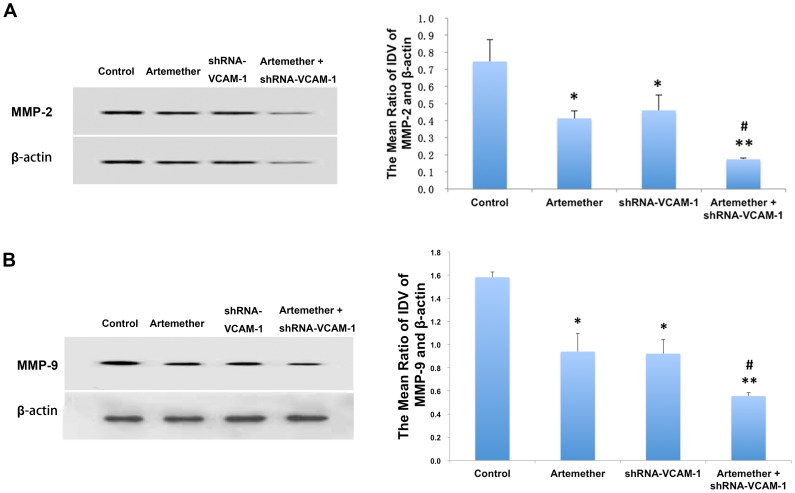
The effects of artemether, shRNA-VCAM-1 and artemether combined with shRNA-VCAM-1 on the expression of MMP-2 and MMP-9.U87 cells were treated with artemether of 300 µmol/L, shRNA transfected or treated with both. Serum free L-DMEM served as a negative control. Expressions of MMP-2/9 were checked with Western Blot. (A) Effects of artemether, shRNA-VCAM-1 and artemether combined with shRNA-VCAM-1 on the expression of MMP-2. (B) The effects of artemether, shRNA-VCAM-1 and artemether combined with shRNA-VCAM-1 on the expression of MMP-9. Statistical analysis showed that artemether and shRNA-VCAM-1 significantly reduced the expression levels of both MMP-2 and MMP-9 proteins compared with control group. Artemether+shRNA-VCAM-1 displayed the maximum inhibition on the expression of MMPs compared with single artemether or shRNA-VCAM-1 groups. *P<0.05, **P<0.01 (compared with control group); #
P<0.05 (compared with artemether or shRNA-VCAM-1 group). n = 4.